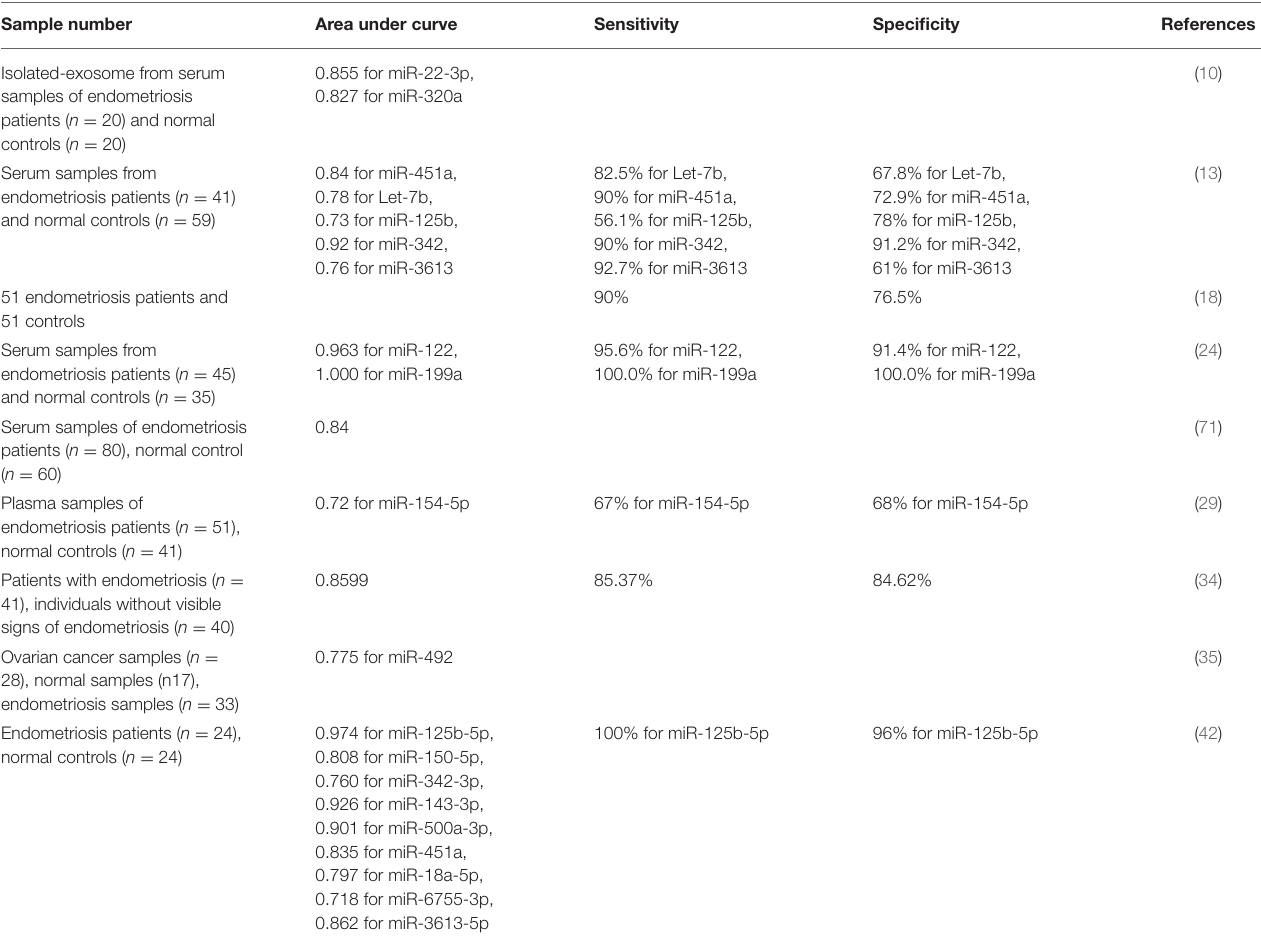
TABLE 3 | Diagnostic value of miRNAs in endometriosis.